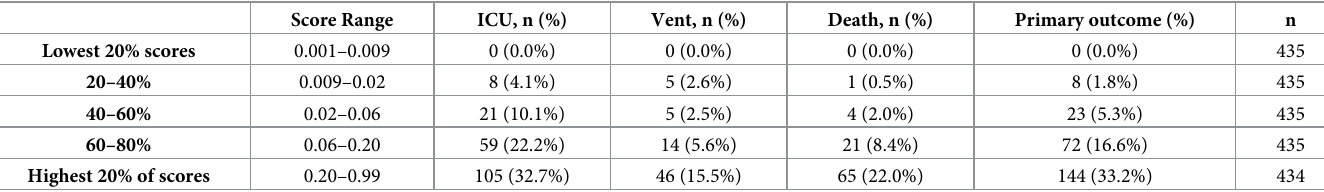
Table 3. Distribution of outcomes by score ranges in quintile for the real-time validation data set (n = 2,174). Score Range